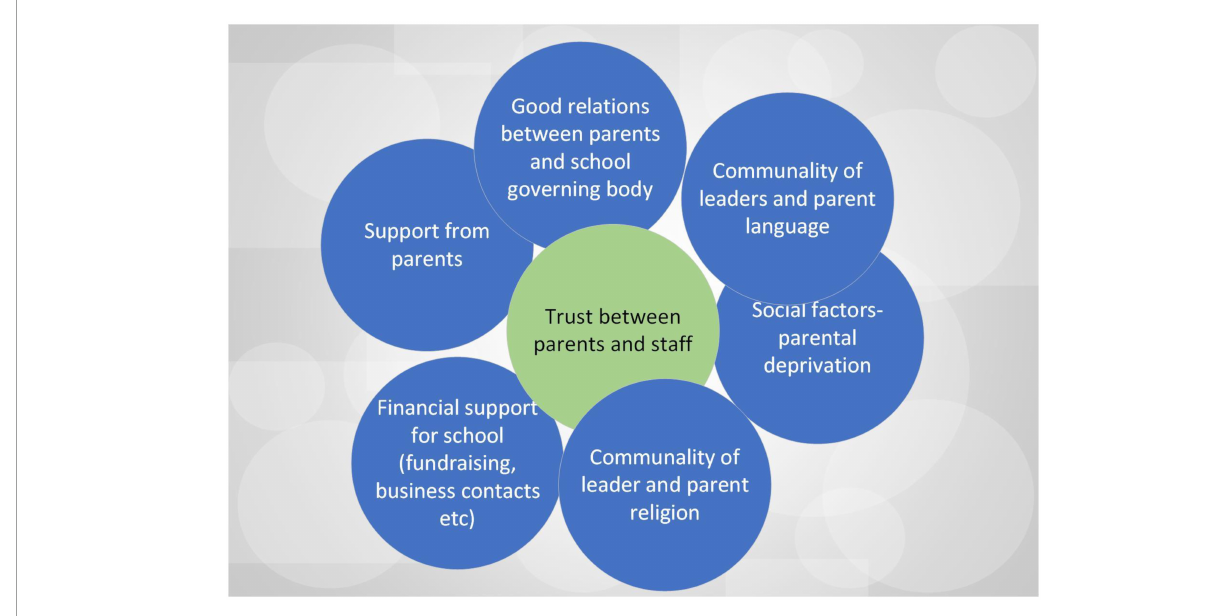
FIGURE3 Key trust factors in relation to parental trust in leadership.